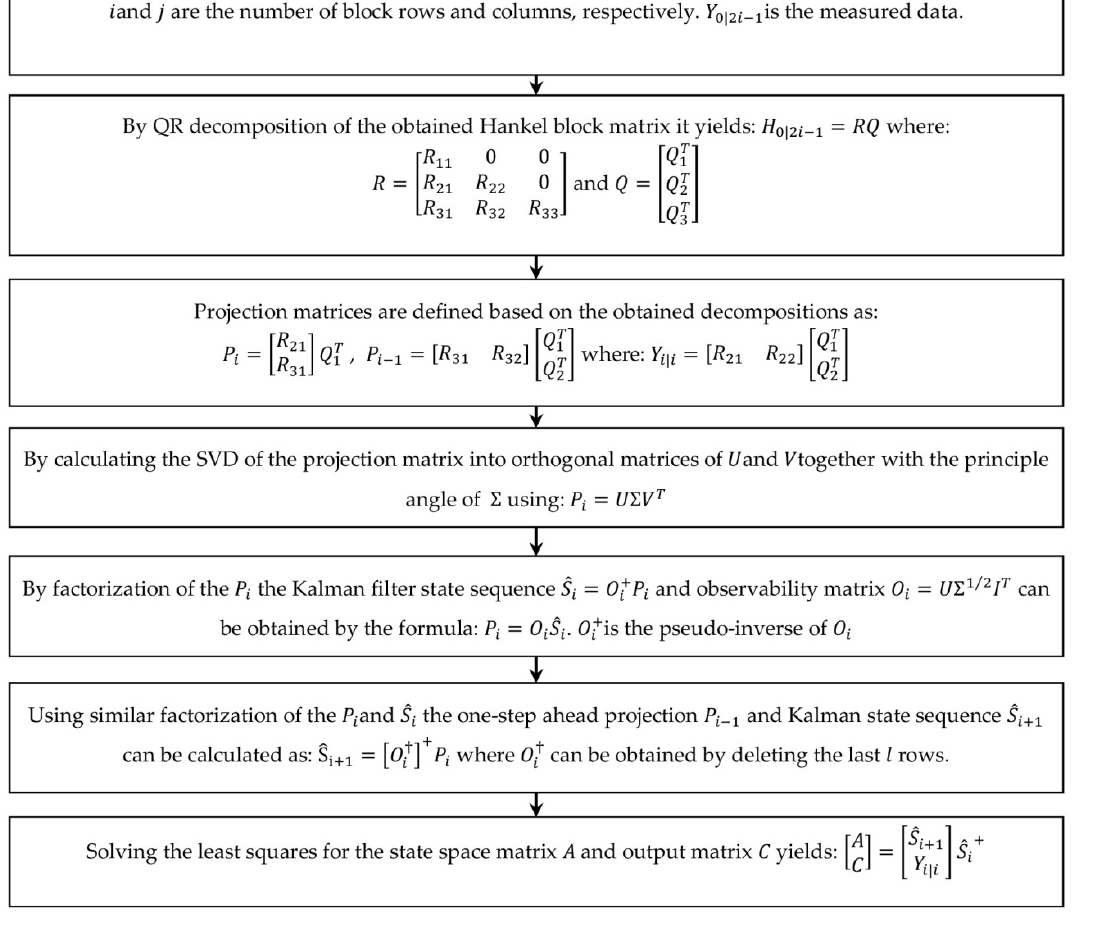
Figure 1. Methodology of the data-driven stochastic subspace identification (SSI-DATA) technique.